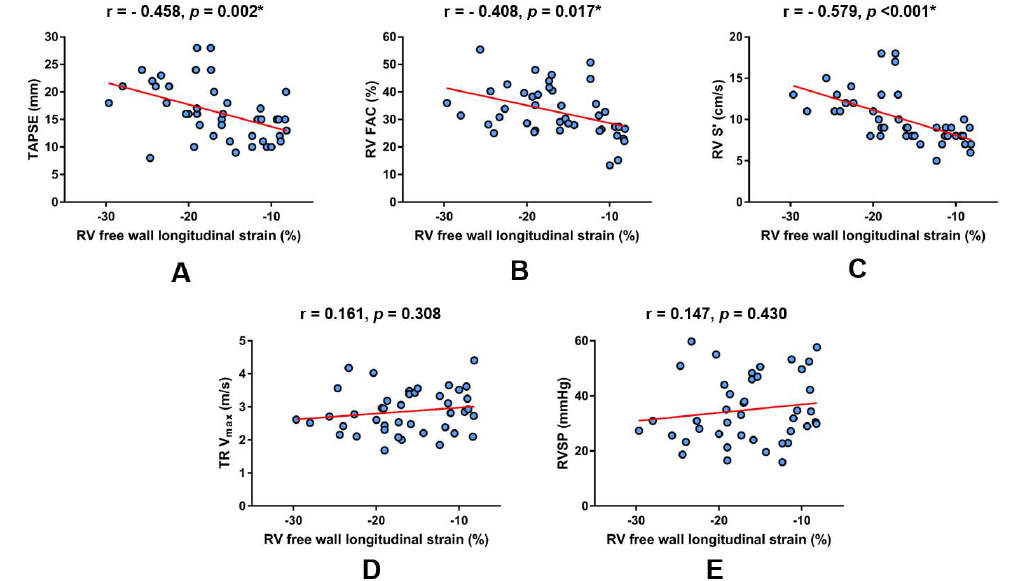
Figure 3. Linear regression plots showing the correlation of RV free wall longitudinal strain with respect to other echocardiographic parameters of RV function and estimated RV systolic pressure in the total patient cohort ( n = 42). ( A ) TAPSE, ( B ) RV FAC, ( C ) RV S (cid:48) , ( D ) TR Vmax, ( E ) RVSP. * Significant statisticalassociationattwo-tailedlevel.r-Pearson’scorrelationcoe ffi cient. Abbreviations: RVFAC-right ventricular fractional area change; RV S (cid:48) -myocardial systolic excursion velocity; RVSP-right ventricular systolic pressure (estimated); TAPSE-tricuspid annular plane systolic excursion; and TR V max -maximal tricuspid regurgitation